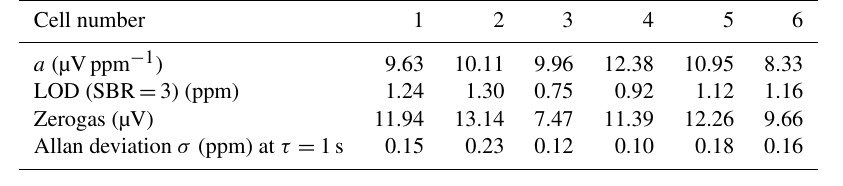
Table 4. Parameters from the concentration curves for all cells: slope of the concentration curves a , LOD (based on SBR = 3, calculated according to Eq. 3), zerogas signal, and the Allan deviation at an averaging time of 1s (taken from Fig. 5a).